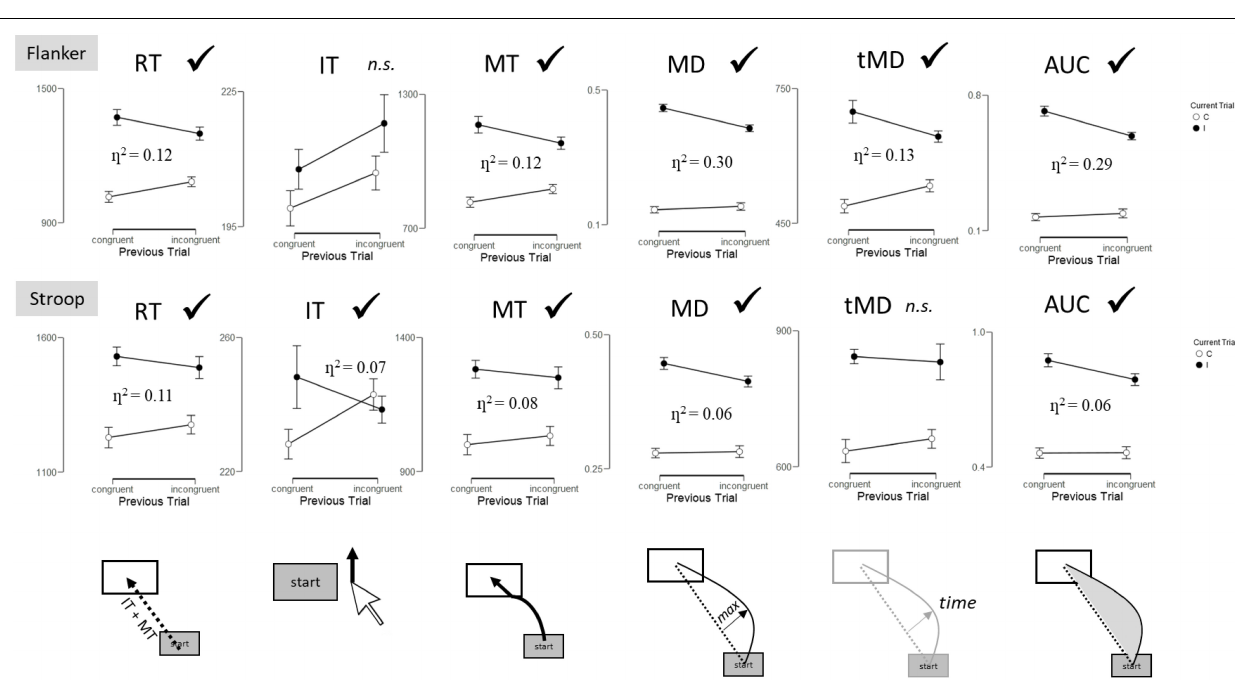
FIGURE 3 | Sequential congruency effects (interaction between Current Trial and Previous Trial) by task and dependent variable. RT, Reaction Time; IT, Initiation Time; MT, Movement Time; MD, Maximum Deviation; tMD, Time to Maximum Deviation; AUC, Area Under the Curve. Checkmarks indicate significant effects ( p < 0.05). n.s.,